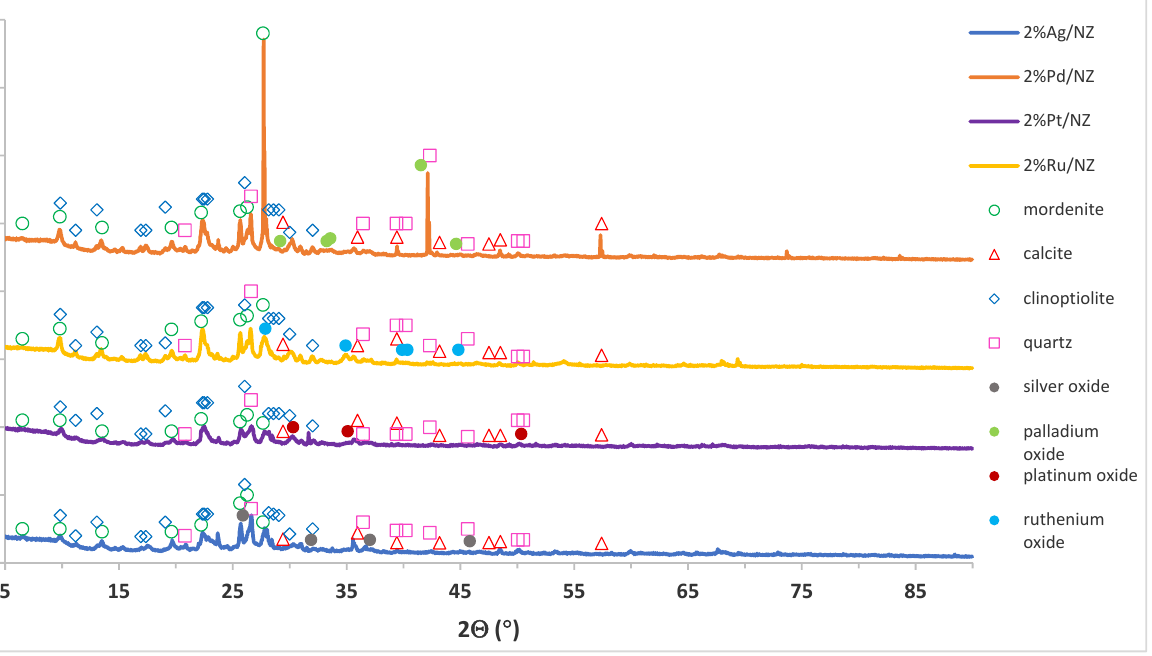
Figure 4. XRD diffraction curves of the calcined monometallic 2%M/NZ (where M = Ag, Pd, Pt, Ru) catalysts in an air atmosphere at 400 °C for 4 h.